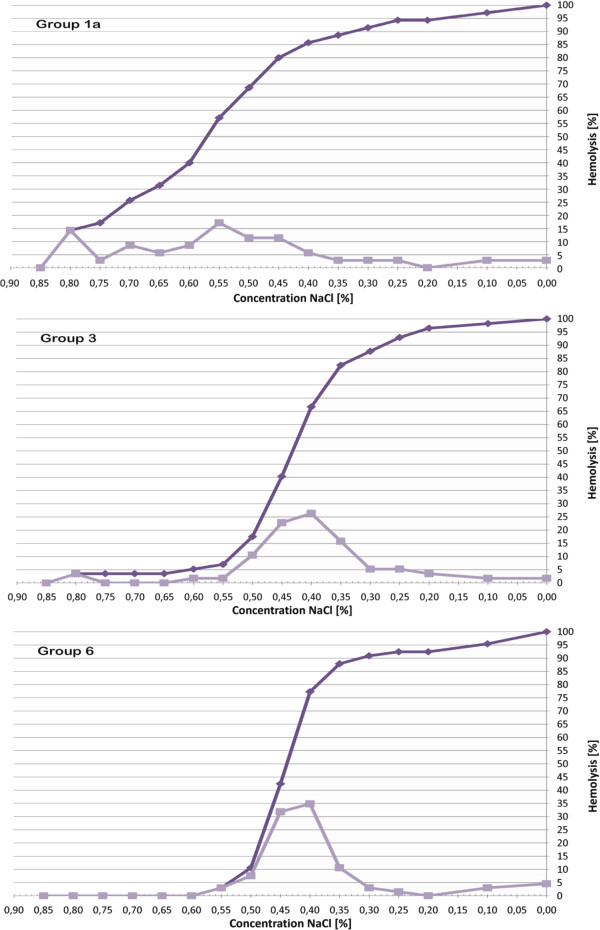
Cumulative and derivative fragiligram for group 1a (IMHA), group 3 (hyperlipidemia) and group 6 (healthy dogs). The cumulative (dark line) and derivative (light line) fragiligrams are based on the mean values for OF5, OF50 and OF90 of group 1a (dogs with IMHA), group 3 (dogs with hyperlipidemia) and group 6 (healthy dogs) in the COFT. The figure shows a marked left shift of the cumulative and derivative fragiligram in dogs from group 1a, while no obvious left shift of the fragiligrams is present in dogs from group 3 or group 6. Furthermore, it can be noticed that the NaCl concentration at which 5% of the erythrocytes are haemolysed is higher for group 3 than for group 6, which indicates that in group 3 a small subpopulation of erythrocytes has an increased osmotic fragility.